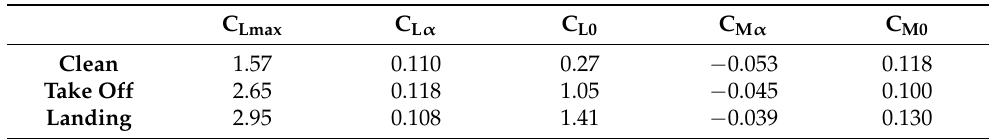
Table 13. Numerical results for low-speed conditions, untrimmed maximum lift coefficient,